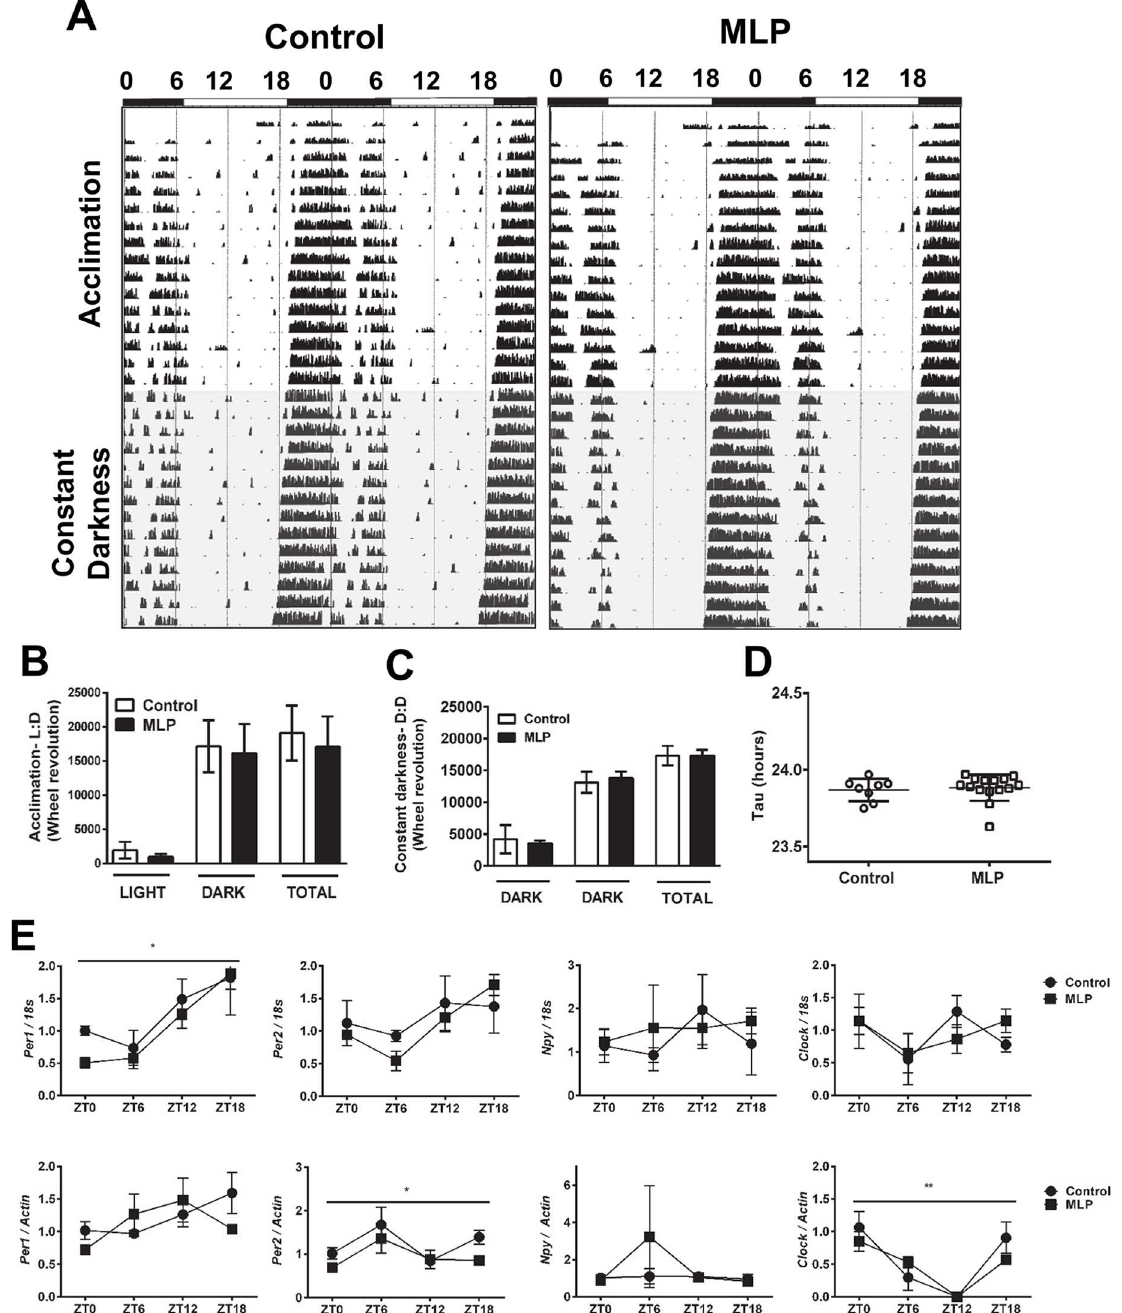
Fig 3. Circadian physical activity and gene expression is not affected in MLP male offspring mice. (A) Representative double-plotted actogram for control (left panel)and MLP (right panel)offspring. Zeitgeber times (ZT) (0, 6, 12, 18) are represented on top. Black and white blocks belowZT’s indicatedark andlight conditions,respectively. Mice wereindividuallyhousedfirst in 12 h light:12h dark for acclimation (L:D) (white background, top half) then in constant darkness(D:D) (gray background, bottom half). Black notchesrepresentactivity. The total wheelrevolutionsduringfinal 10 days of the (B) acclimation(Control,n = 9; MLP, n = 15), (C) constant darkness(Control, n = 8; MLP, n = 15), and(D) Periodicity(Tau) (Control, n = 8; MLP, n = 15) is shown. (E) Total RNA (mRNA) from hypothalamus of MLP and control offspring(n = 3/time point/group) after two weeks housingunder L:D cycle wereextracted at ZT 0, 6, 12, or 18. Data shownis relativegeneexpression for indicated circadiangenes(numerator) over the housekeeping genes 18s and Actin (denominator) .All data are presentedas mean ± SEM. P < 0.05was considered statistically significantby Mann-Whitney U test for (A-D) andby 2-wayANOVA with Bonferronicorrectionfor (E). * indicates statistically significanteffect of Zeitgeber time points betweencontrol and MLP